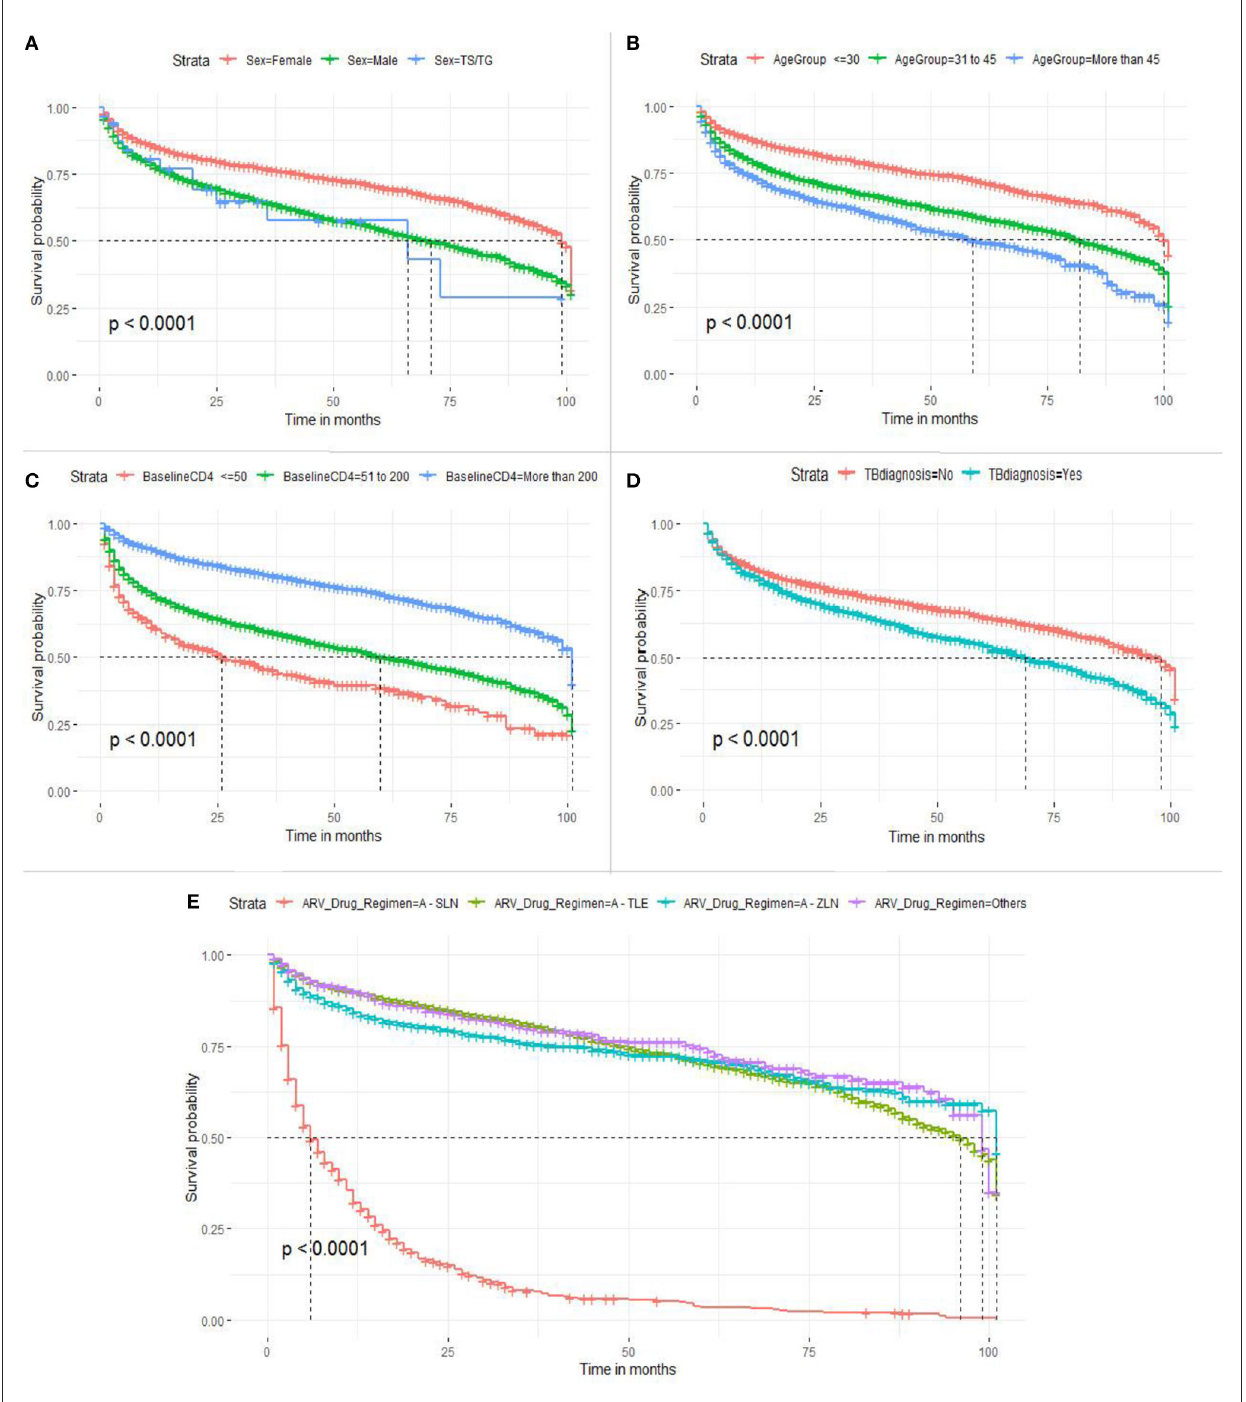
FIGURE2 Kaplan-Meier Survival curves showing intergroup differences with respect to (A) Sex, (B) Age, (C) CD4 Count, (D) Tuberculosis (TB), and (E) ART Regimen.